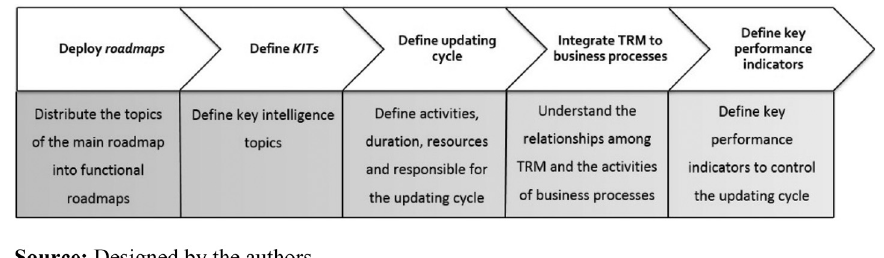
Figure 2. Flow of activities of the planning